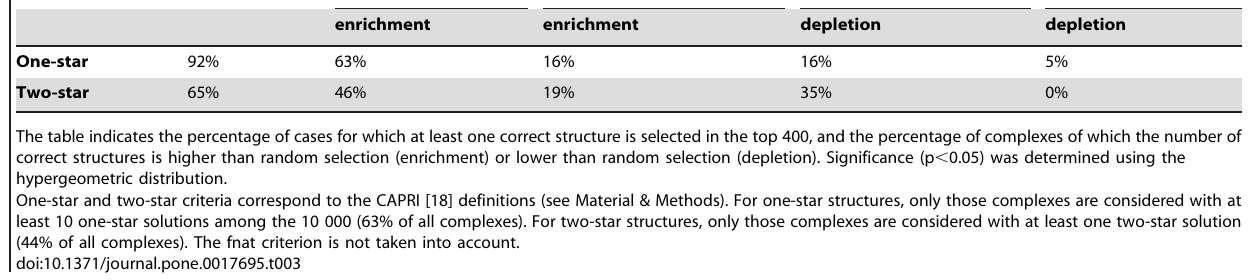
Table 3. Scoring of docking solutions at the rigid body stage of the CPORT docking runs.